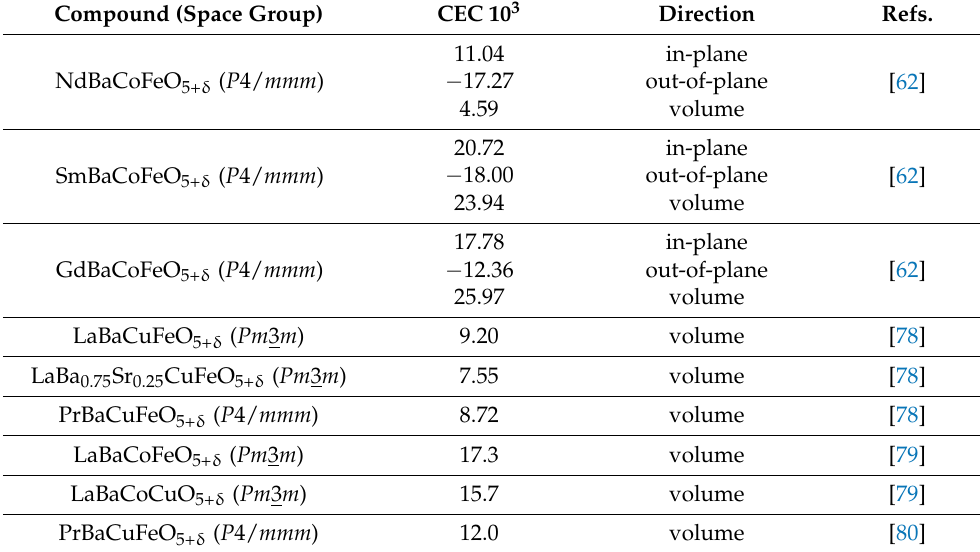
Table 2. CEC values of some layered oxygen-deficient